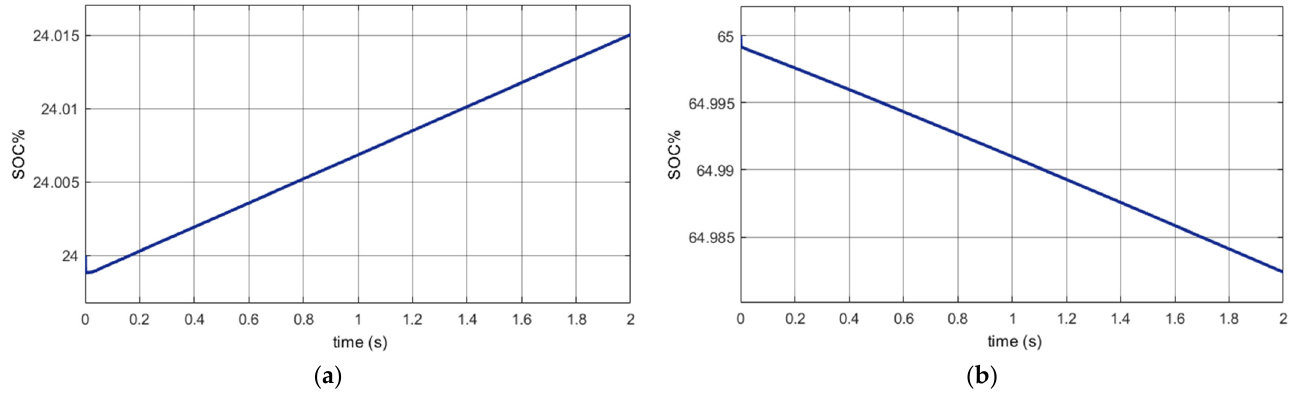
Figure 13. SOC of the EV and the storage ba tt ery. ( a ) EV SOC. ( b ) Storage ba tt ery SOC.